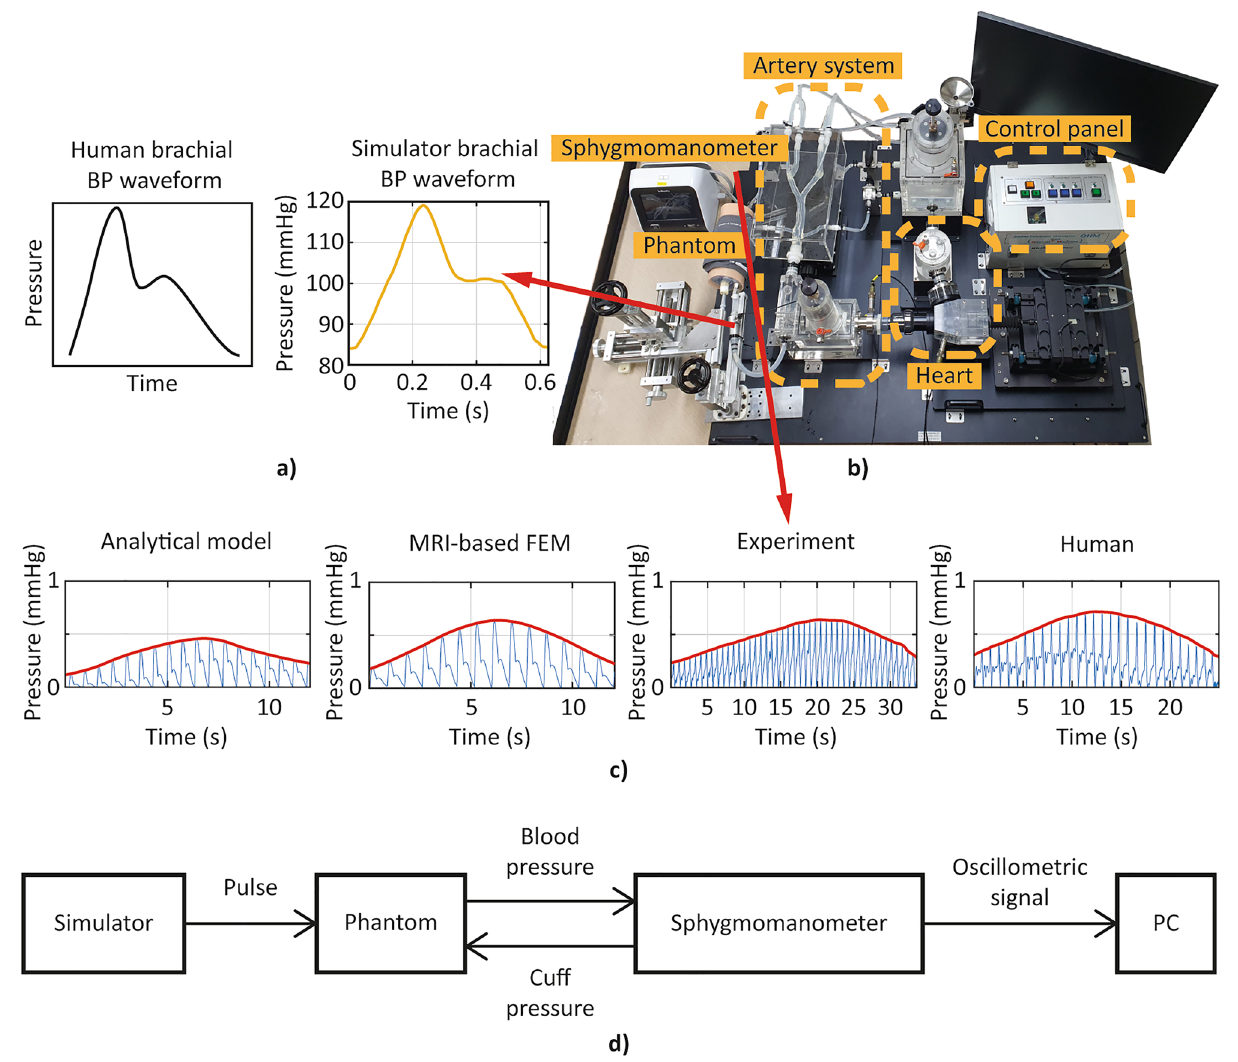
Figure 4. Experimental setup and flow chart with the cardiovascular simulator and the signals obtained from the experiment. ( a ) Human brachial pulse waveform and that created by the cardiovascular simulator, recorded just before the phantom, ( b ) Experimental setup with the cardiovascular simulator: pump mimicking heart is actuated to create the pressure waveform that reproduces the pulse wave in the human circulatory system, ( c ) Oscillometric signals obtained from the analytical model, MRI-based FEM model, experiment, and human, respectively. ( d ) Flow chart of the experimental Evaluation index. Meaningful range. Unlike the signals obtained from the simulation with modeling, each oscillometric signal obtained from the experiment had a different time length depending on the maximum pressure the device inflated. Hence, in this work, a “meaningful range” was set (Fig. 5a), where evaluating indices were defined to compare the signals from the commercial BP device without undesired bias. The meaningful range was set according to the maximum amplitude algorithm 33 (MAA), which is the most generally used al- gorithm for commercial automatic sphygmomanometers. In the MAA, the systolic blood pressure (SBP) and diastolic blood pressure (DBP) were estimated to be the cuff pressures that matched to the amplitudes of certain ratios to the maximum amplitude of the oscillometric signal. According to Geddes 33 , the most generic ratios are 0.55 before maximum for SBP and 0.82 after maximum for DBP. Therefore, the point where the amplitude is 0.55 of the maximum amplitude before maximum value, and the point where the amplitude is 0.82 of the maximum amplitude after the maximum are set as each end of the meaningful range. From here, the amplitude and the shape of the oscillometric signal could be evaluated. Amplitude index. The amplitude of the oscillometric signal was evaluated by the mean amplitude of the signal envelop within the meaningful range, as shown in Fig. 5a.